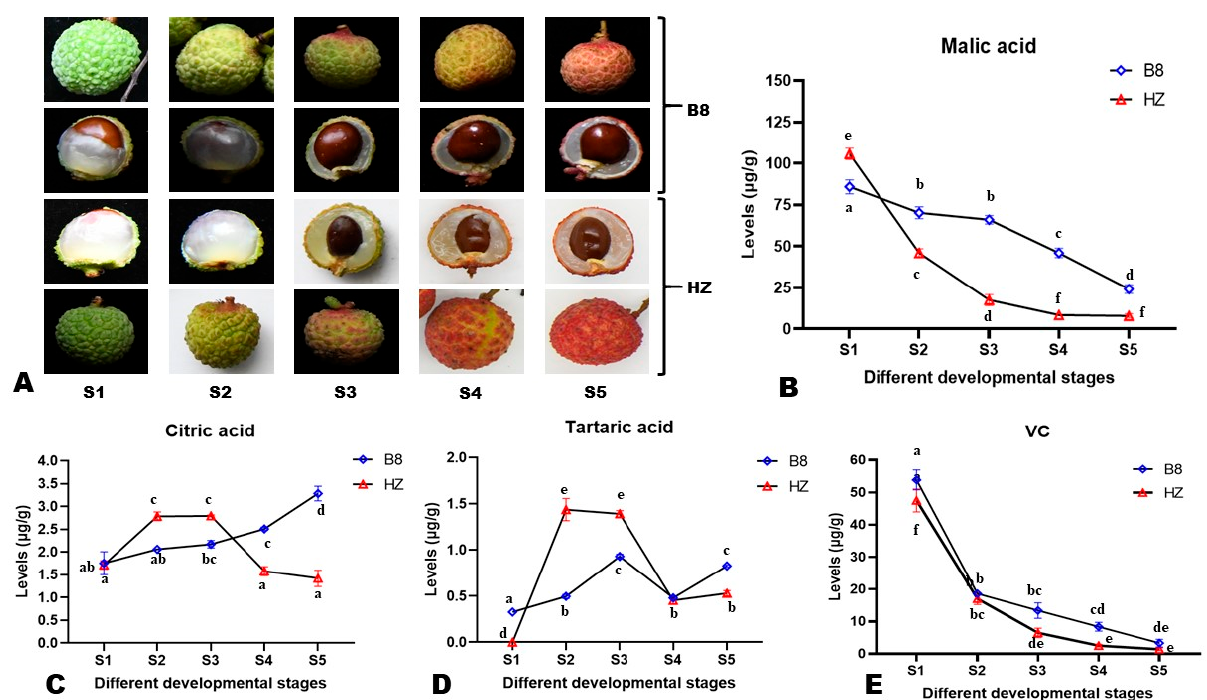
Figure 1. Morphological observation of litchi fruits and pulps from HZ and B8 and different developmental stages ( A ). Overview of the dynamic changes in the content of malic acid ( B ), citric acid ( C ), tartaric acid ( D ), and VC ( E ) in HZ and B8 during fruit ripening. S1, S2, S3, S4, and S5 represent different developmental stages. Each value is expressed as mean ± standard error (n = 3). Different letters display significant ( p < 0.05) differences (one-way ANOVA) for each organic acid at the different fruit developmental stages in the two